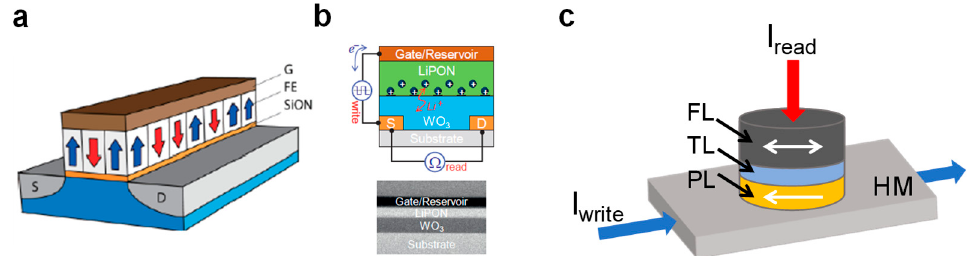
Figure 12. Sketch of three fundamental examples of three-terminal memristive devices. ( a ) Schematic structure of ferroelectric field-e ff ect transistor (FeFET) device, where the ferroelectric switching phenomenon allows the transistor threshold voltage to be modulated, thus gradually changing the channel conductivity. ( b ) Schematic structure of electro-chemical random access memory (ECRAM) device, where the channel conductivity is controlled by the migration of ion species, e.g., Li + ions, into an electrolyte material being induced by the voltage applied at the gate terminal. ( c ) Schematic structure of spin-orbit torque magnetic random access memory (SOT-MRAM), where the current flow in a heavy metal (HM) line causes a polarization switching in the MTJ-free layer, resulting in a device conductance change. Reprinted with permission from [107,108]. Copyright 2017, IEEE. Copyright 2018, IEEE.